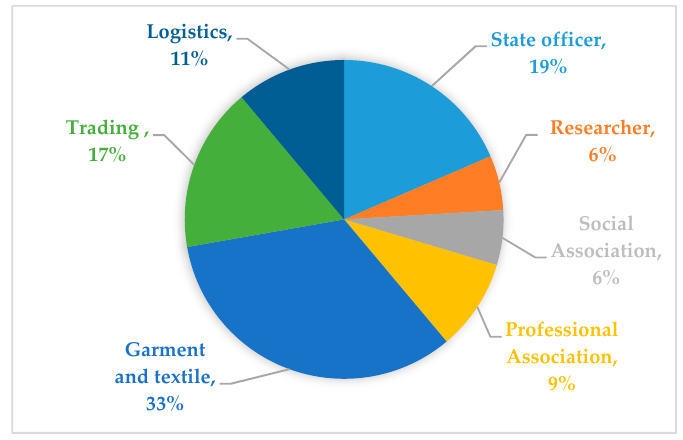
Figure 1. The composition of the sample respondents (Source: Authors’ analysis).